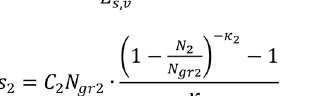
Figs. 9a and 9b show the linear distribution { τ using Eqs. (25), (29), (30). C the least squares method. Figs. 10a and 10b show the linear distribution for { τ